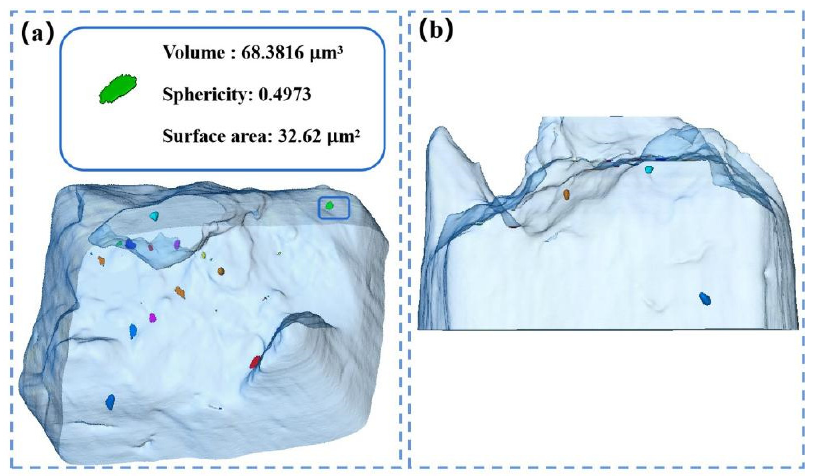
Figure 11. ( a ) Top view of fracture imaging, ( b ) side view of fracture imaging.